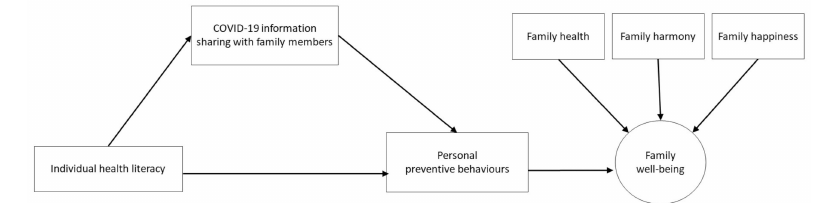
Figure 1. Proposed model of health literacy, preventive behaviours and family